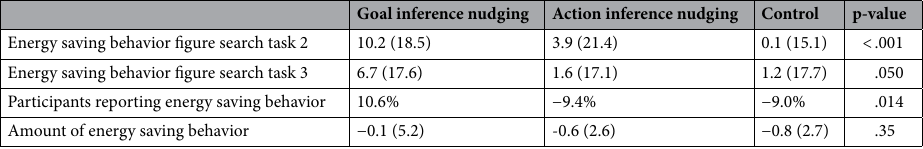
Table 2. Means, SDs, and regression-estimated effects of condition for increase in pro-environmental behavior compared to baseline in Study 1. The table reports the average and standard deviations (in parentheses) of increase in pro-environmental behavior compared to baseline in Study 1, and the p-value of the effect of condition in an ANOVA for each